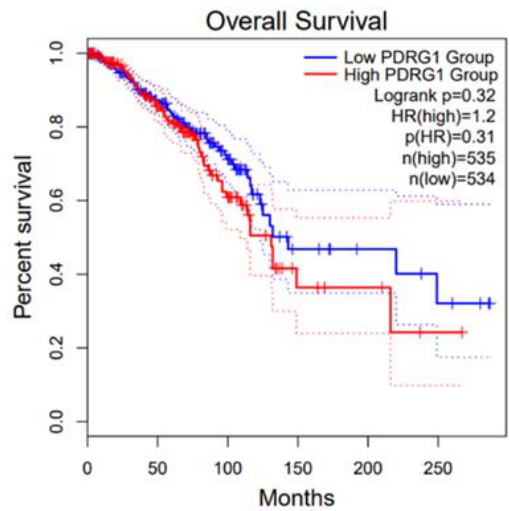
Table 2. Results of multivariate Cox regression model for age, stage, and C/N ratio of MAT2A expression.